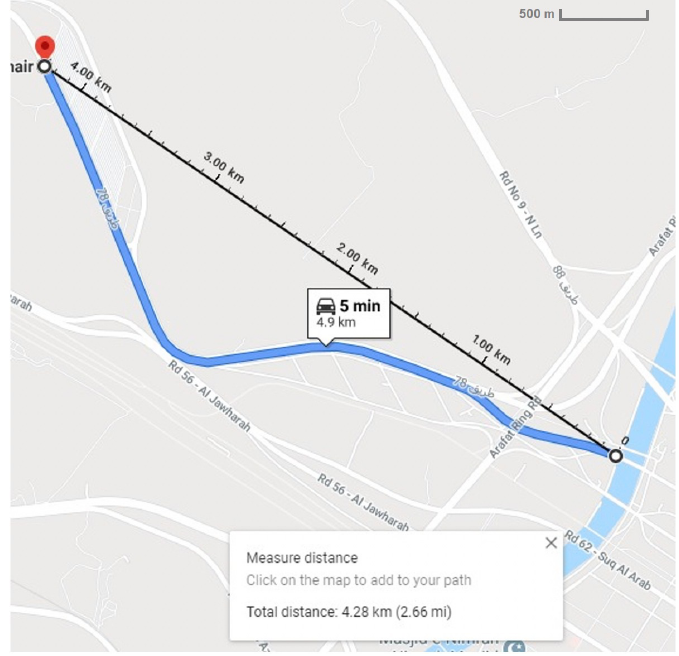
Figure 8. Data before interpolation (Image from Google Maps).